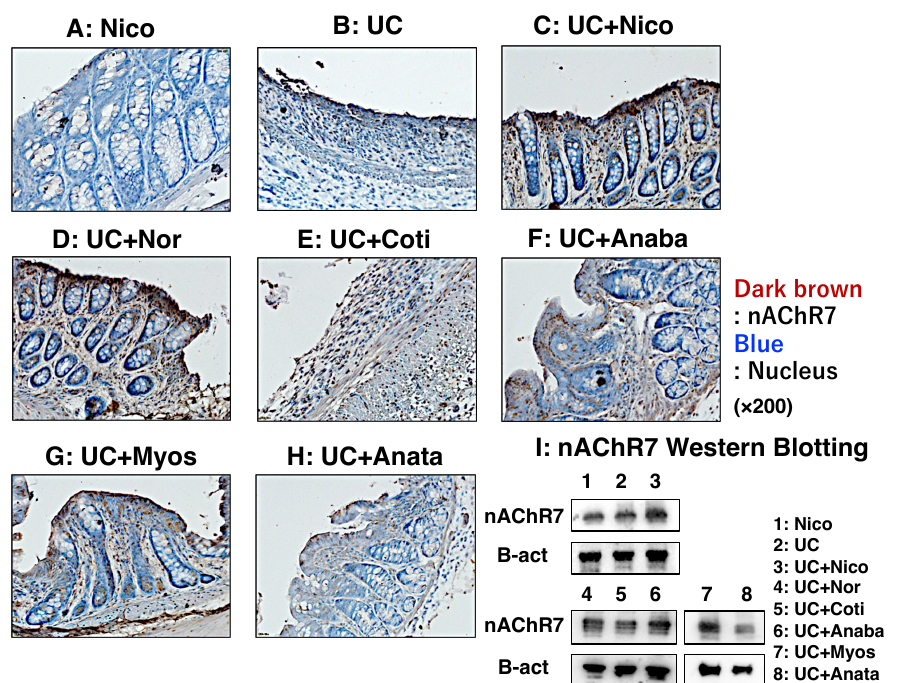
Figure 6. Evaluation of nAChR7 expression in colonic tissues of rats. ( A – H ) Results of immune staining with DAB to visualize nAChR (dark brown) in the colon tissues of the Nico, UC, UC + Nico, UC + Nor, UC + Coti, UC + Anaba, UC + Myos, and UC + Anata groups, respectively. Nuclei were stained blue with hematoxylin. All microscopic images were observed using a BIOREVO BZ-9000 microscope (Keyence Co., Ltd., Osaka, Japan). High power magnification was used for all panels ( × 200). ( I ) Western blotting was performed to detect nAChR7 expression in the rat colon tissues. The upper and lower panels show the expression of nAChR7 and β -actin (an internal control) proteins, respectively. Each lane 1–8 shows the results of the Nico, UC, UC + Nico, UC + Nor, UC + Coti, UC + Anaba, UC + Myos, and UC + Anata groups. Anaba, anabasine; Anata, anatabine; Coti, cotinine; Myos, myosmine; nAChR7, α 7 nicotine acetylcholine receptor; Nico, nicotine; Nor, nornicotine; and UC, ulcerative colitis. Table 4. The colonic mRNA expression levels of nAChR7 measured by real-time PCR. Relative Amount of Colonic nAChR7 Levels (vs. Nico